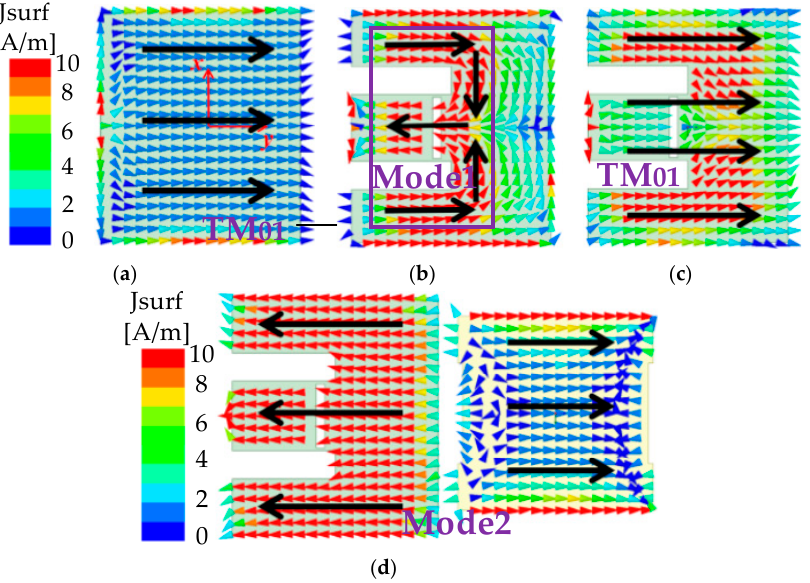
Figure 6. Current distributions and current paths. ( a ) TM 01 mode of Ant1; ( b ) Mode1 at f 1 , 3.3 GHz; ( c ) TM 01 at f 2, 3.58 GHz; ( d ) Mode2 at f 3, 3.84 GHz.